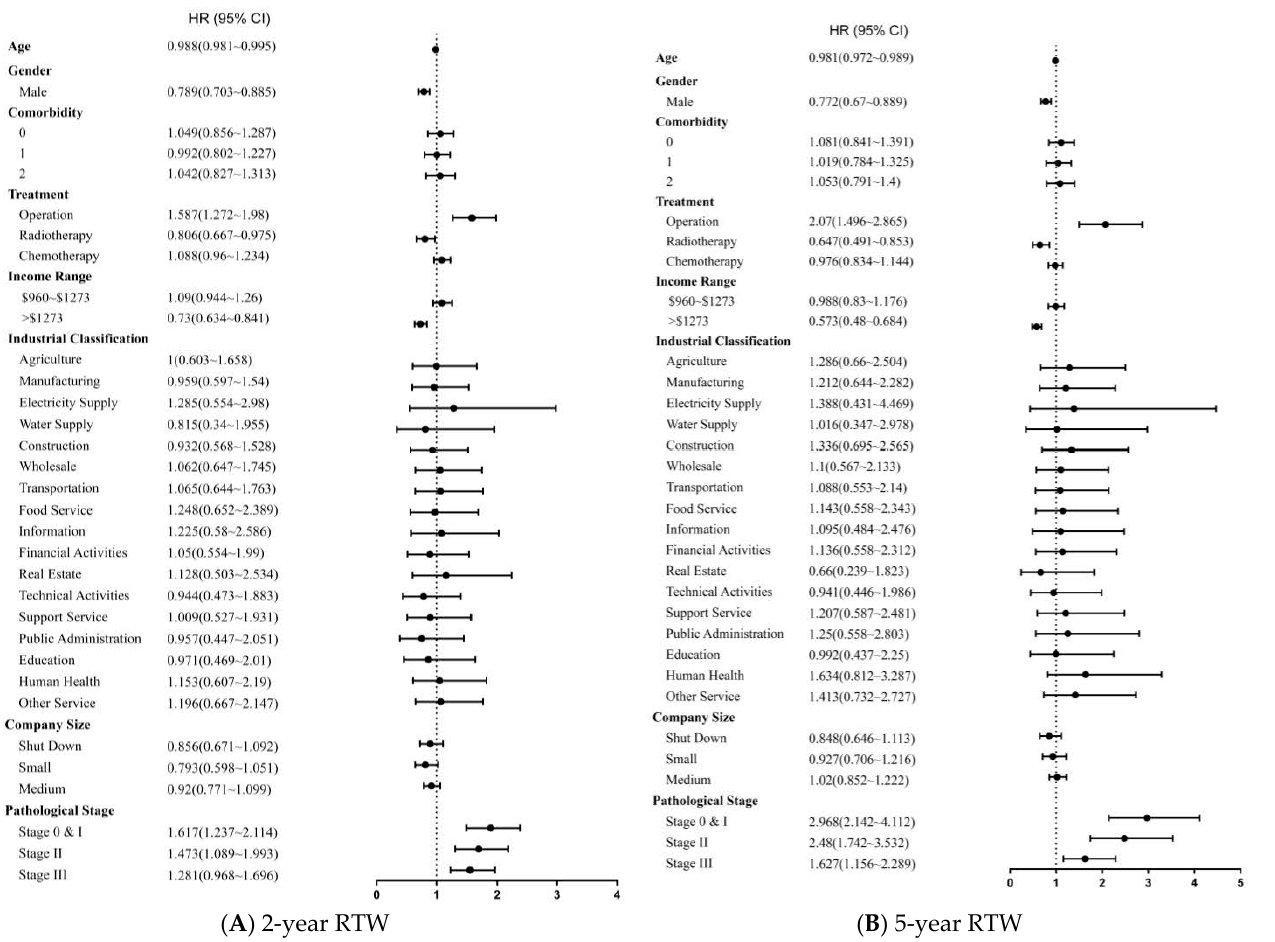
Figure 3. Forest tree plot showing the HR obtained by multivariate Cox proportional hazards model of return to work for lung cancer survivors in ( A ) 2-year RTW and ( B ) 5-year RTW.